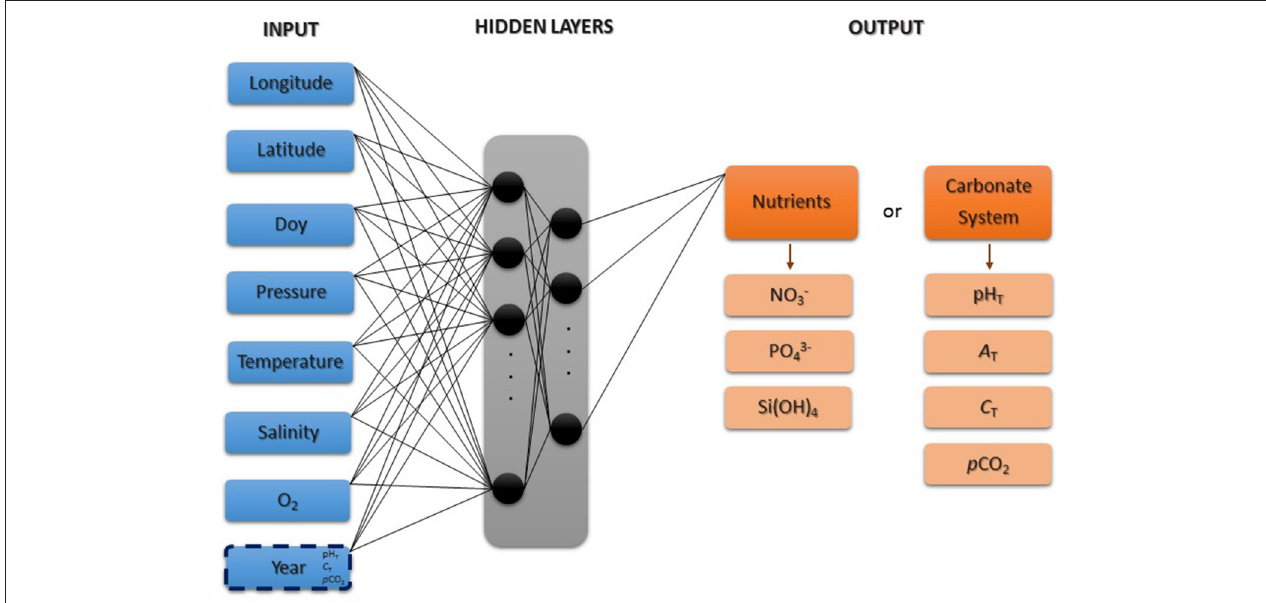
FIGURE 2 | Schematic representation of the CANYON MLP-based neural-network algorithm that retrieves the concentrations of nutrients [NO 3 − , PO 43 − , and Si(OH) 4 ] and the parameters of the carbonate system in seawater (pH T , A T , C T , and p CO 2 ). The input variables are field measured temperature, salinity, O 2 , and hydrostatic pressure (i.e., depth) together with the geolocation and time of sampling. The year is used as input only for retrieving pH T , C T , and p CO 2 . Doy, day of